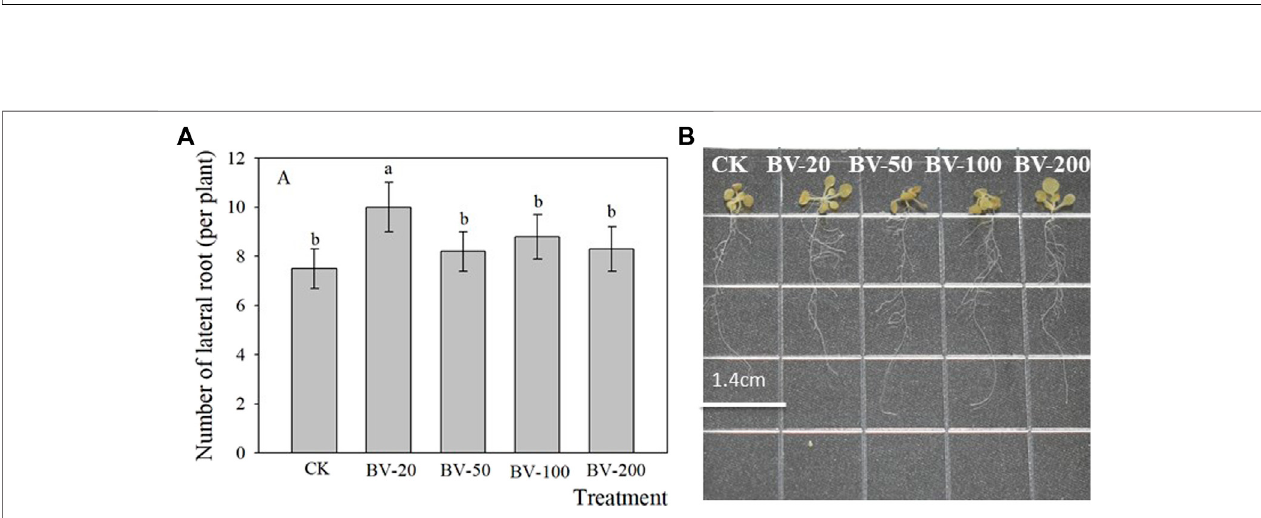
Frontiers in Chemistry |